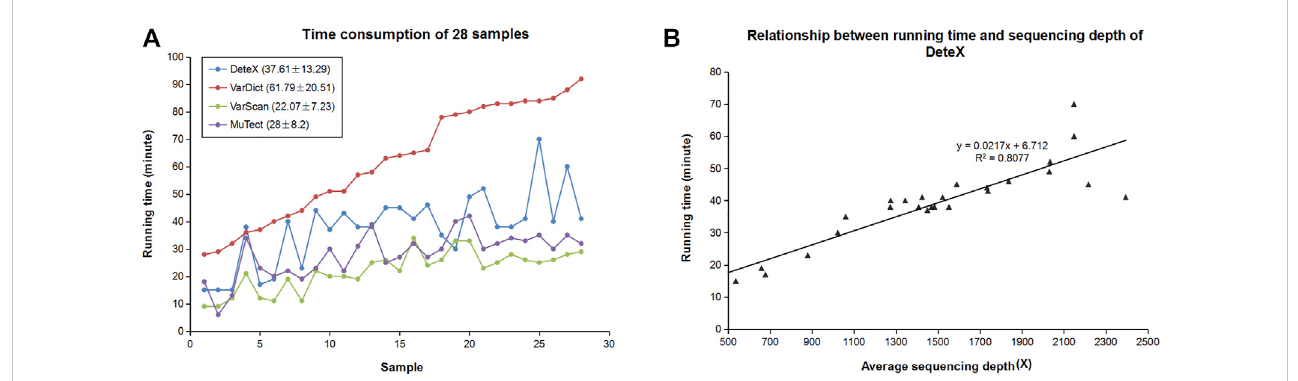
FIGURE 5 Computational performance of DeteX. (A) Time consumption of four callers in 28 clinical samples. (B) The relationship between running time of DeteX and average sequencing